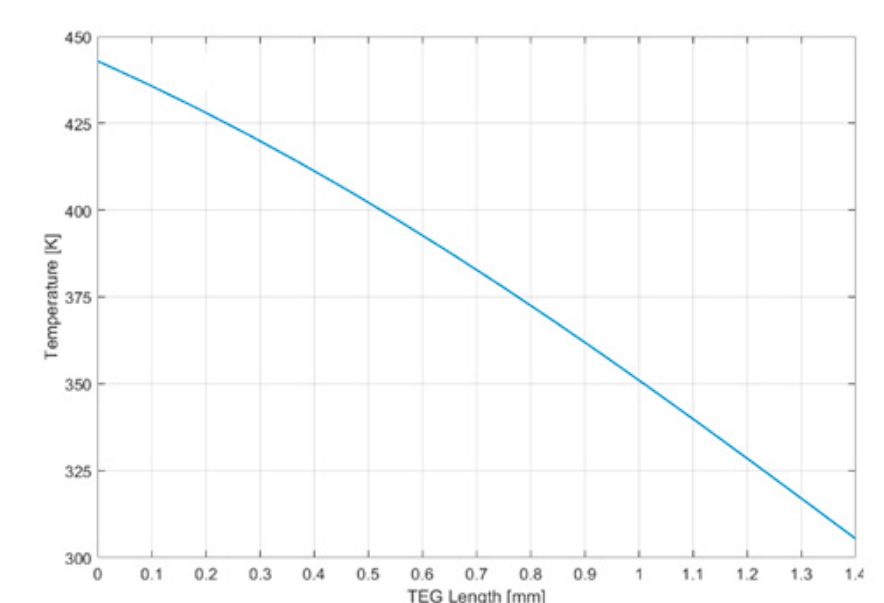
Figure 7. The temperature distribution along TEG legs.